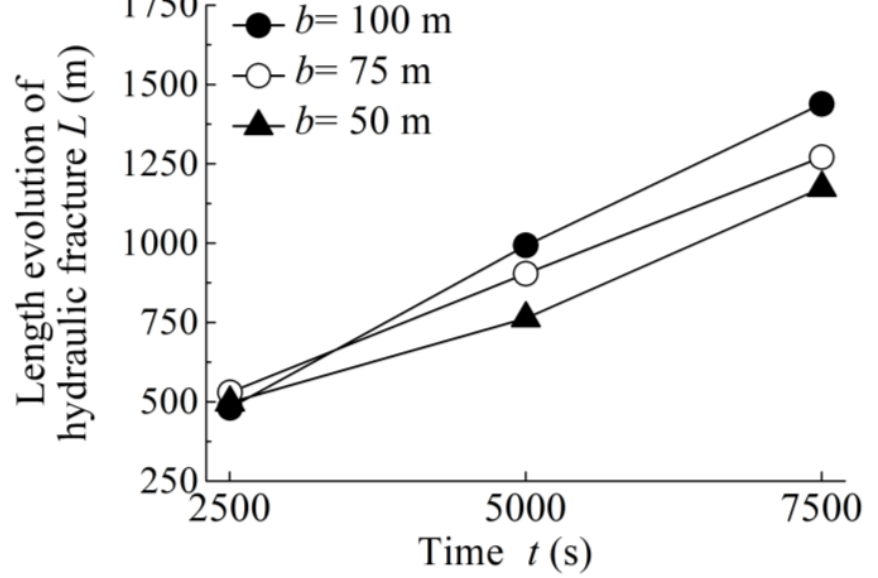
Figure 13. Length evolution of hydraulic fracture for different stages and well spacings.